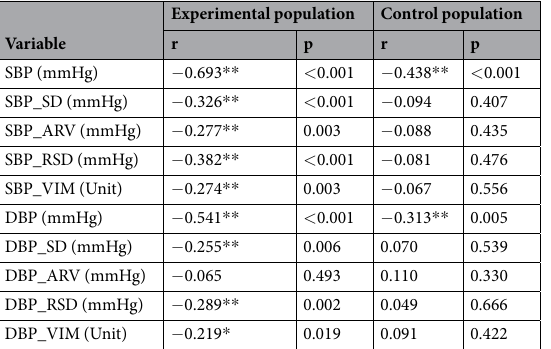
Table 4. The Pearson’s correlations of TAC with beat-to-beat BP and beat-to-beat BPV in hypertensive population and normal population. SBP, systolic blood pressure; DBP, diastolic blood pressure; TAC, total arterial compliance; SD, standard deviation; ARV, average real variability; RSD, residual standard deviation; VIM, variation independent of mean. * p < 0.05; ** P <